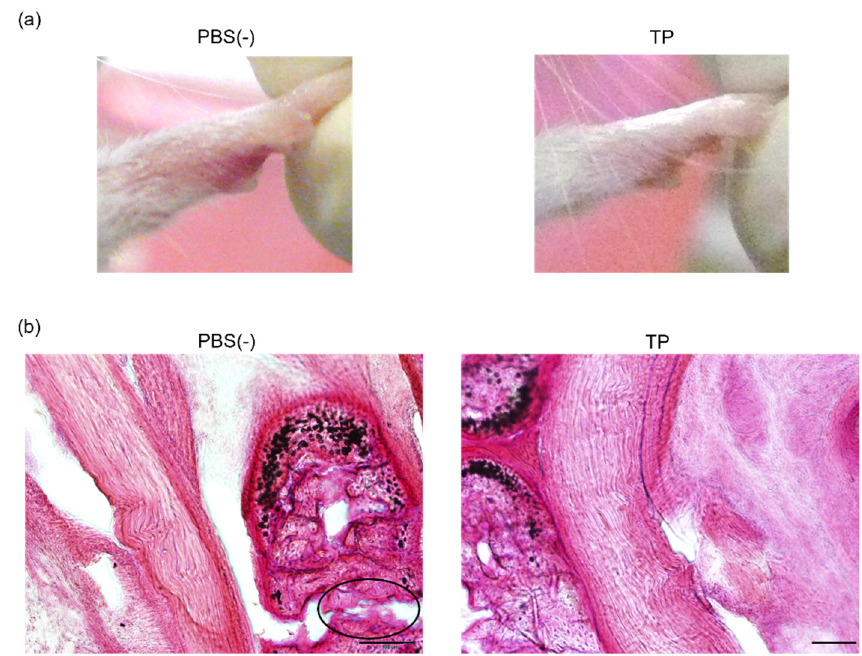
Figure 4. Anti RA effects of TP in laminarin-induced RA model mice. PBS ( − ) and TP dissolved in PBS ( − ) were intraperitoneally administered into mice thrice weekly, 7 days after laminarin injection. ( a ) Typical images of forefoot 21 days after laminarin injection. ( b ) Hematoxylin and eosin stained histological images of joint of forefoot at 49 days after laminarin injection. Area surrounded by a circle of black line indicates infiltrated inflammatory cells.